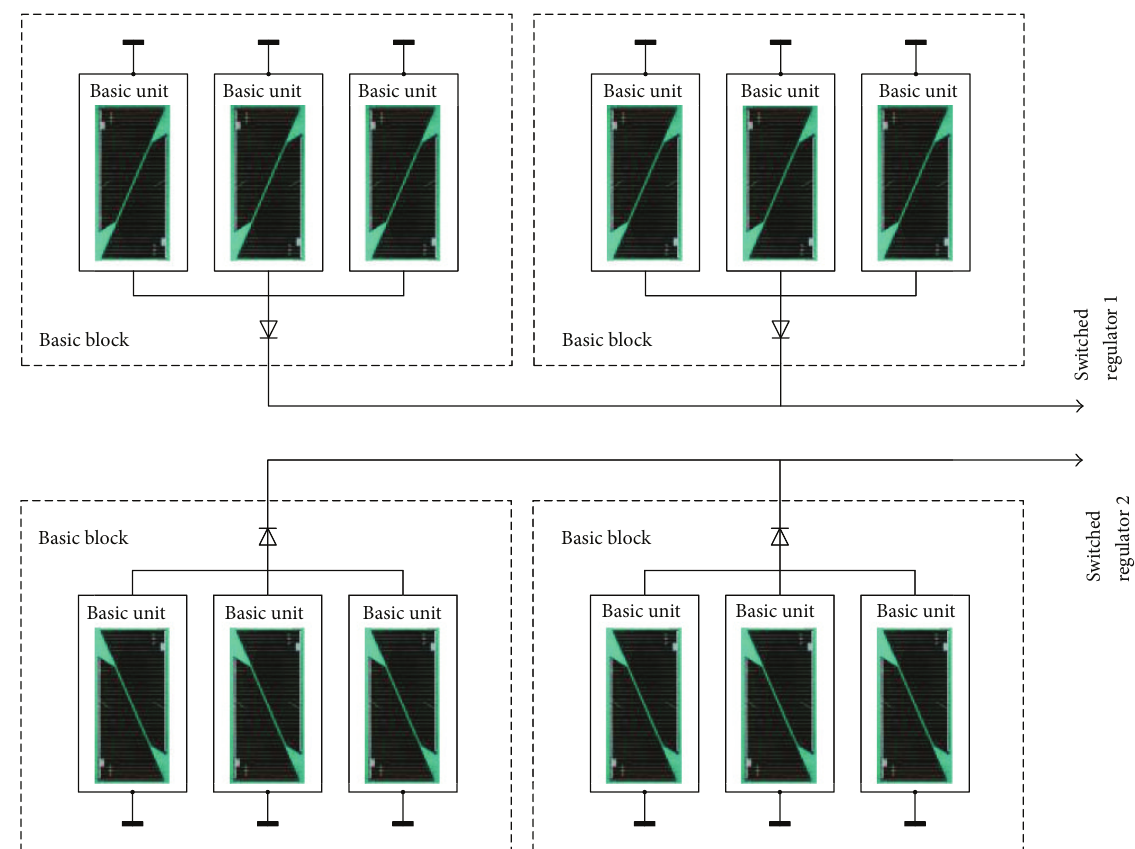
Figure 7: Block topology of proposed solar panel with small TASC